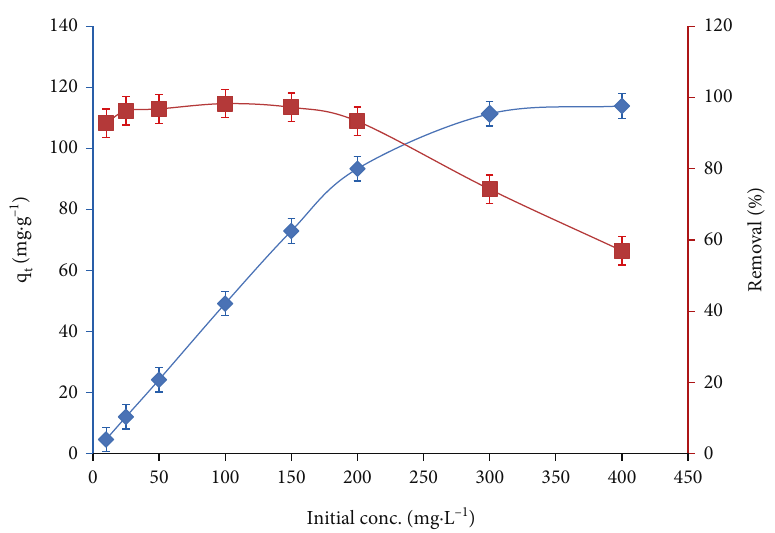
Figure 8: E ff ect of initial concentration on the adsorption of BF on 0.1 g of TKC at 30 ° C.